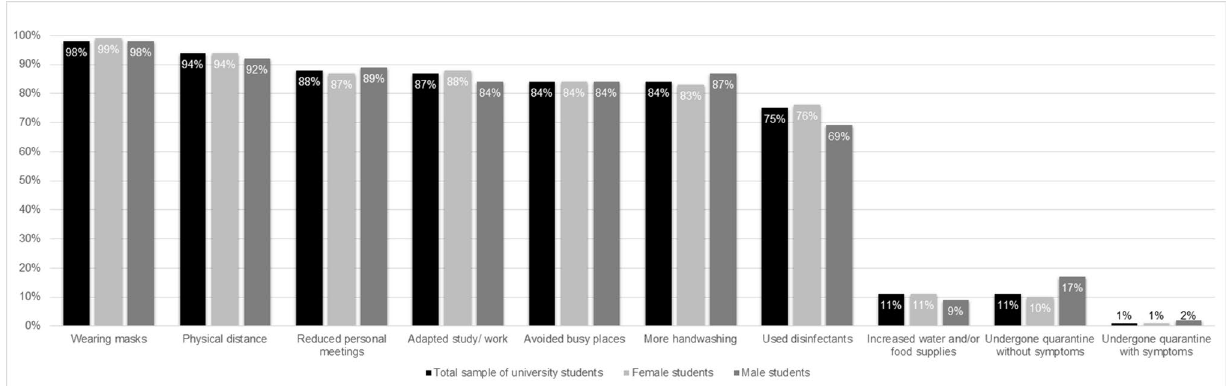
Figure 3. Adherence to pandemic containment measures during the COVID-19 pandemic reported by university students in June 2020 (N =